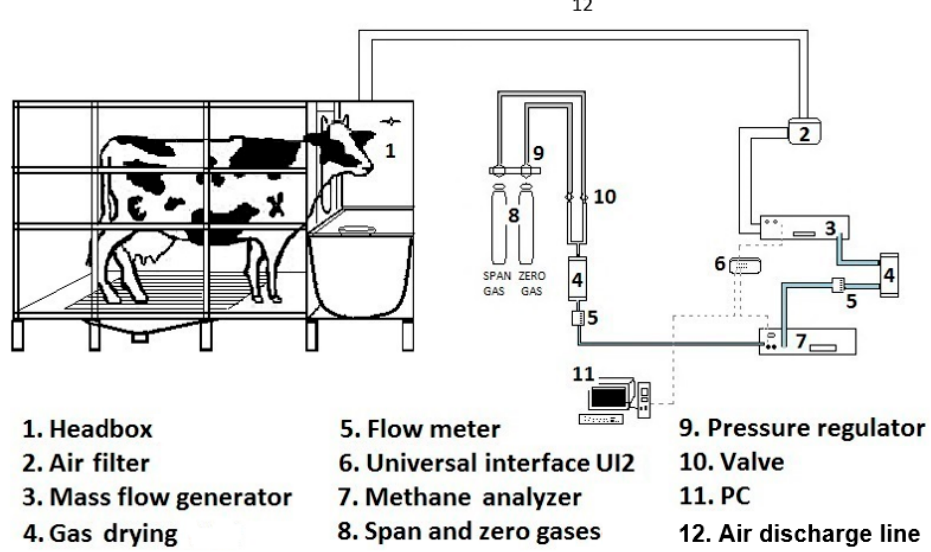
Figure 1. Schematic diagram of the ventilated hood-type open circuit respiration chamber.